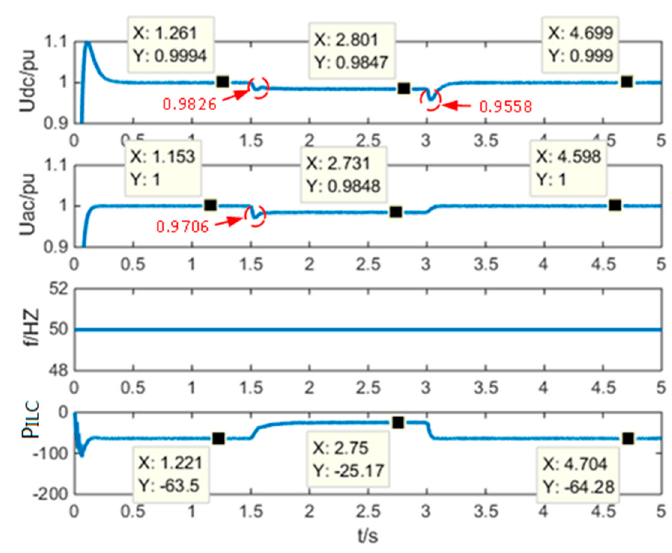
Figure 16. DC voltage, AC voltage, frequency, and ILC transmission power (DC load = 112.5 kW; AC load = 30 kW).